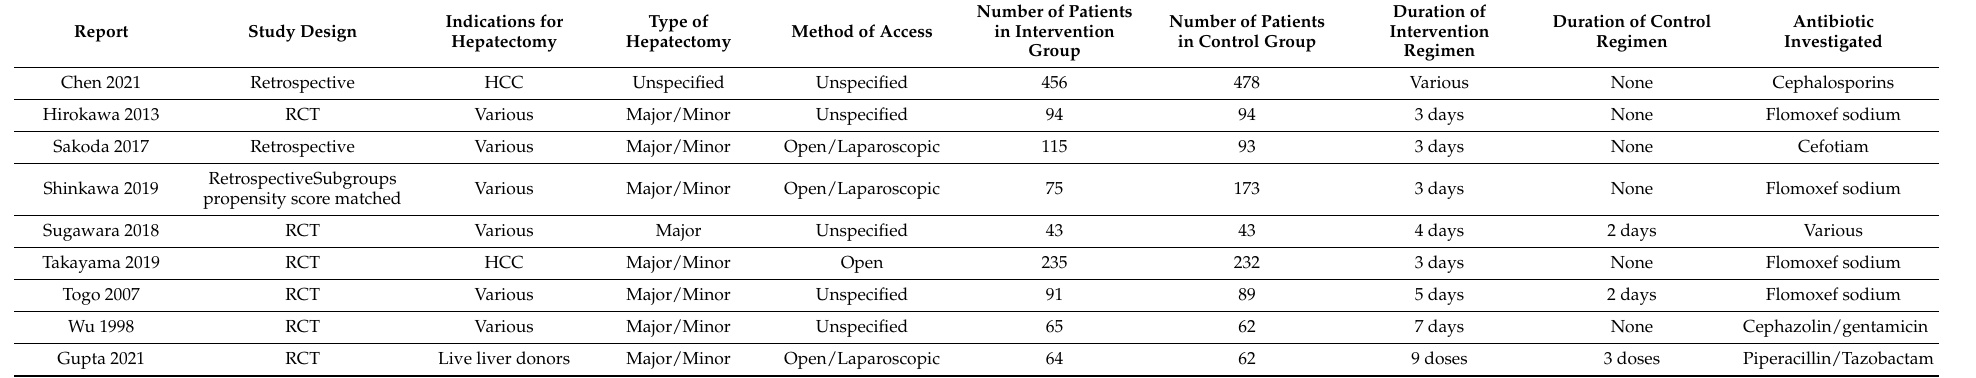
Table 1. Included